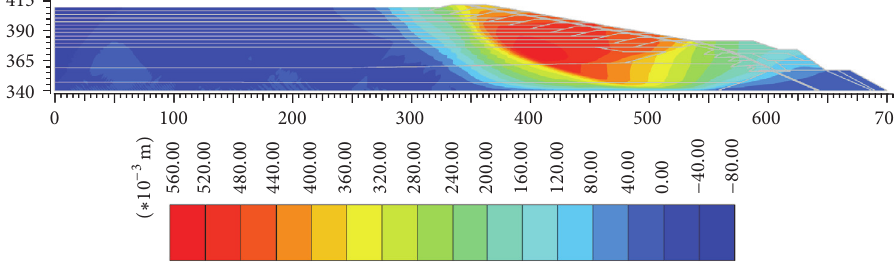
Figure 16: Horizontal displacements in the dam after shaking with extreme earthquake. The positive direction is to the right.